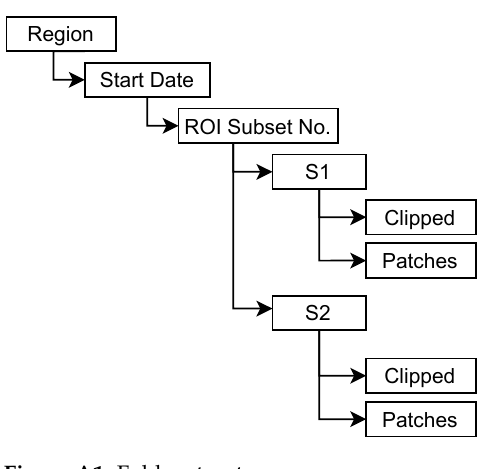
Figure A1. Folder structure.